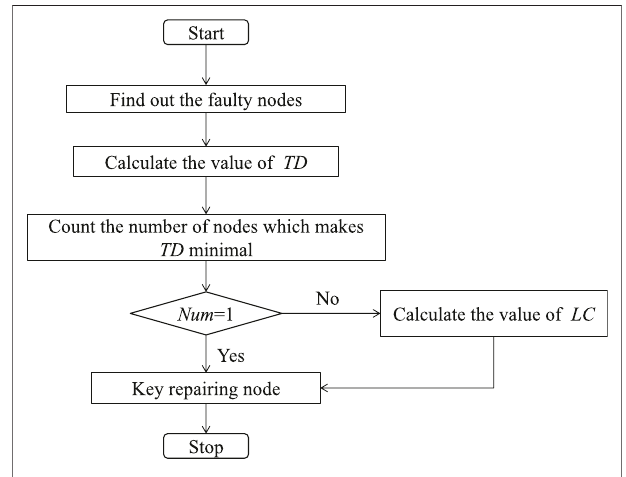
FIGURE 2 | Flow diagram of the proposed key repairing node identi fi cation method.